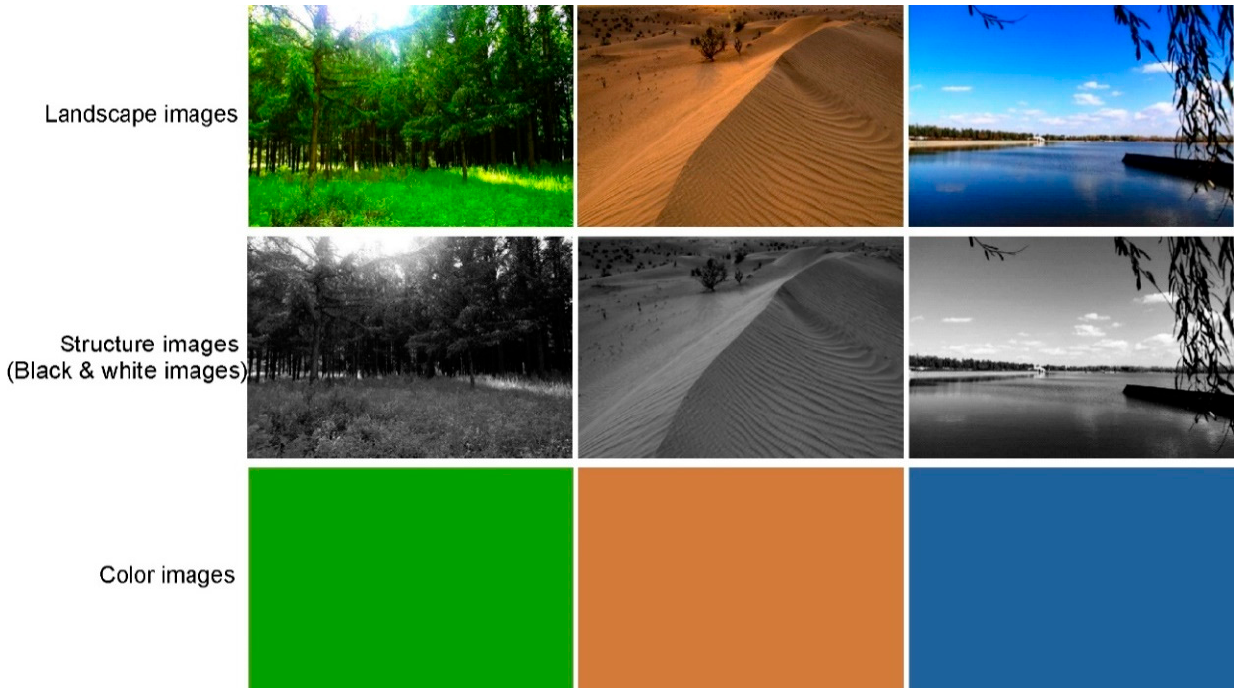
Figure 1. Examples of experimental images.